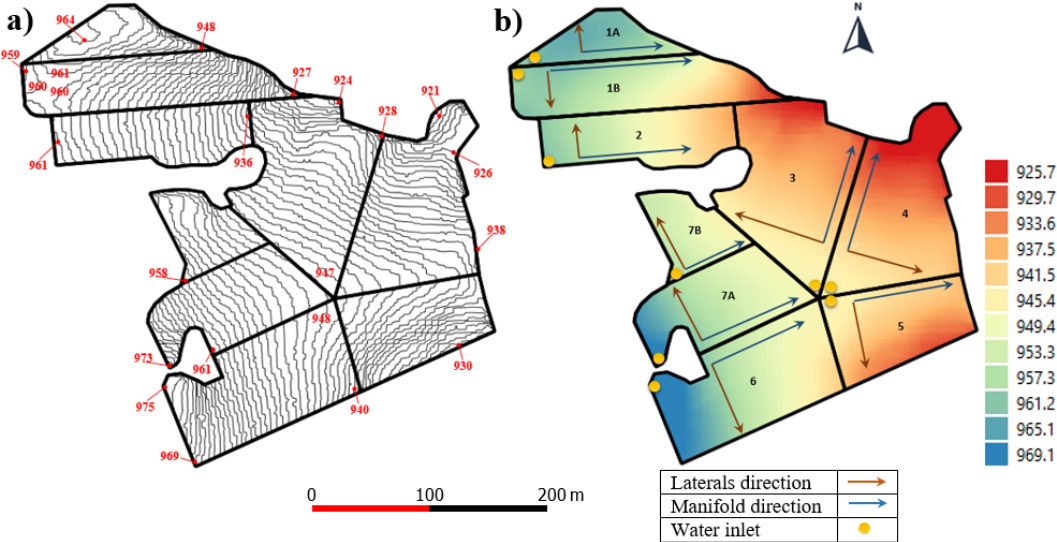
Figure 6. The apple farm subdivided into nine sectors, illustrating ( a ) the 1 m contour lines, and ( b ) the DEM with flow directions for laterals (brown lines) and manifold (blue lines). For each sector, the inlet position (•) is also reported. The geometric parameters, corresponding to the seven sectors (1–7) and those to the splitting of sectors #1 and #7, are reported in Table 6, where the sectors derived by sector #1 and sector #7 are indicated as sector #1A and #1B, and sector #7A and #7B, respectively (background colored). Table 6. Geometric and hydraulic design parameters for the apple farm subdivided into seven or nine sectors, by splitting sectors #1 and #7 in two sectors (background gray colored), characterized by an “almost uniform” slope and planform geometry, designed by IRRILAB, for common emitters (CE) and pressure compensating emitters (PCE).